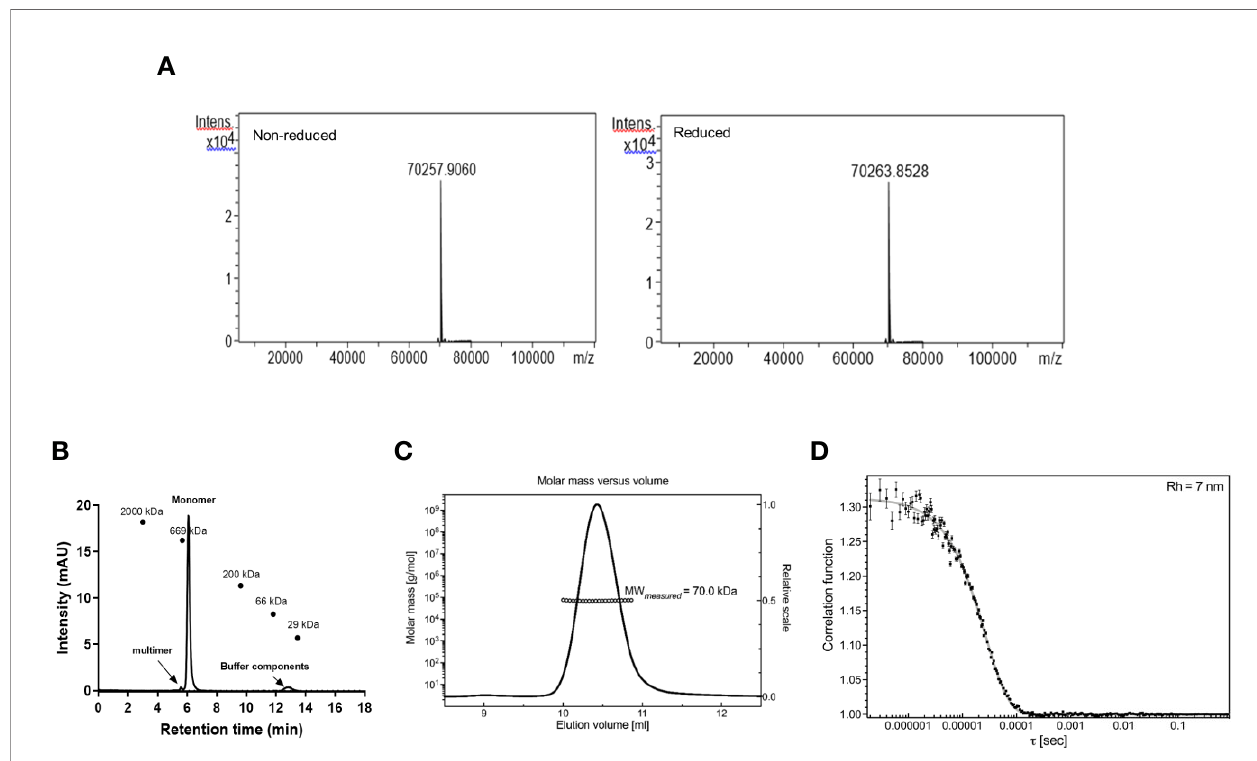
FIGURE 3 | Characterization of R0.6C. (A) deconvoluted mass spectra corresponding to the non-reduced and reduced samples. (B) Size-exclusion chromatography (SEC) HPLC analysis. SEC-HPLC analysis was performed under native conditions in a phosphate buffer pH6.7 to determine the amount of monomer in the sample. The peaks observed at +40 min are due to salts in the buffer matrix. (C) SEC-MALS analysis. R0.6C was injected onto a Superdex 200 Increase 10/300GL column and the change in refractive index as a function of protein concentration was used to compute the molar masses. The solid line plotted on the right axis corresponds to the change in refractive index from the SEC column. The right axis is normalized to the greatest magnitude across the chromatogram data, i.e., to the monomer peak of R0.6C. The molar masses across the eluting peak are plotted as open circles on the left axis (molar mass). The average molecular mass is indicated. (D) QELS goodness of fi t of the auto-correlation function plot at the apex of the